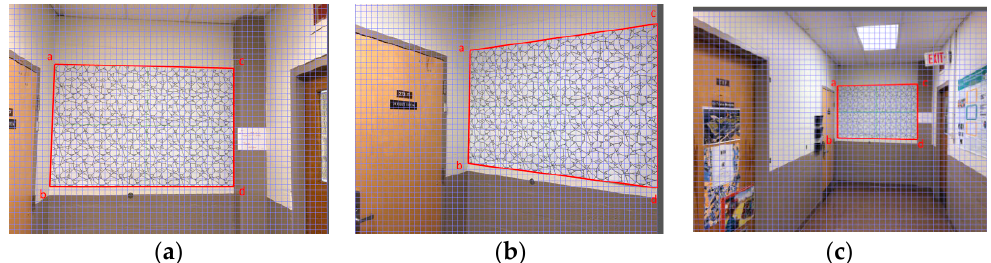
Figure 2. Differences between the reference and current images when the camera’s orientation and position change, which results in transformation of the features of the current images. ( a ) Reference frame; ( b ) Current frame impacted by rotation; ( c ) Current frame impacted by scaling.